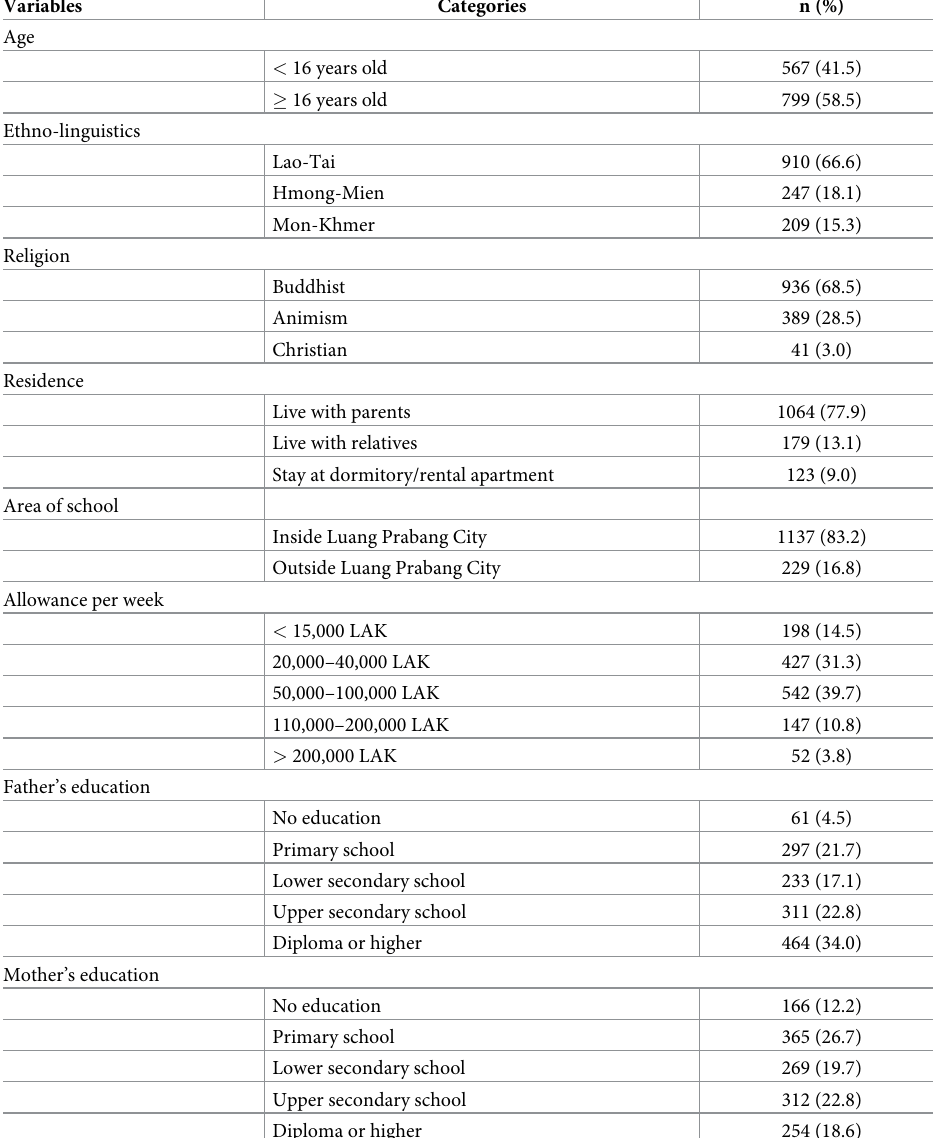
Table 1. Socio-demographic characteristics of secondary school girls in Luang Prabang Province (N =